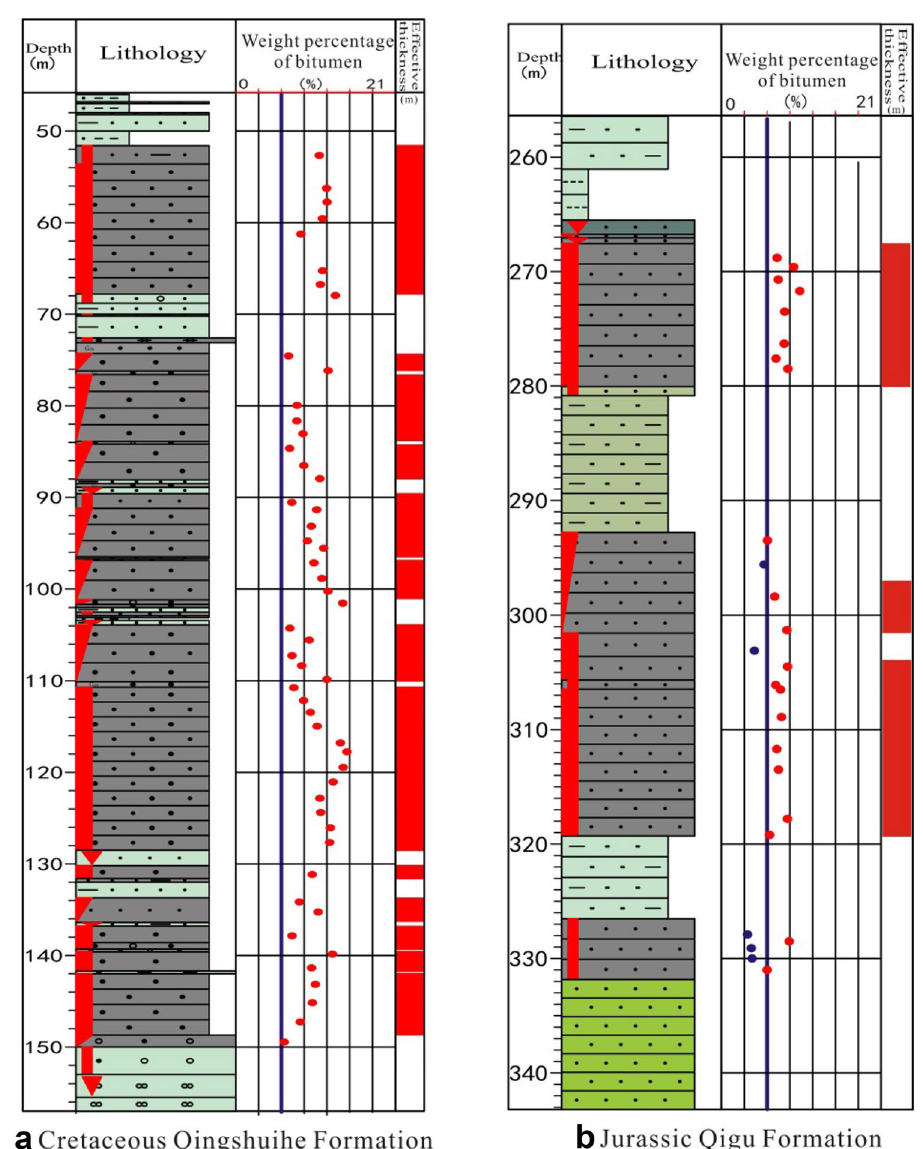
Fig. 3 Composite columnar sec- tion for typical boreholes